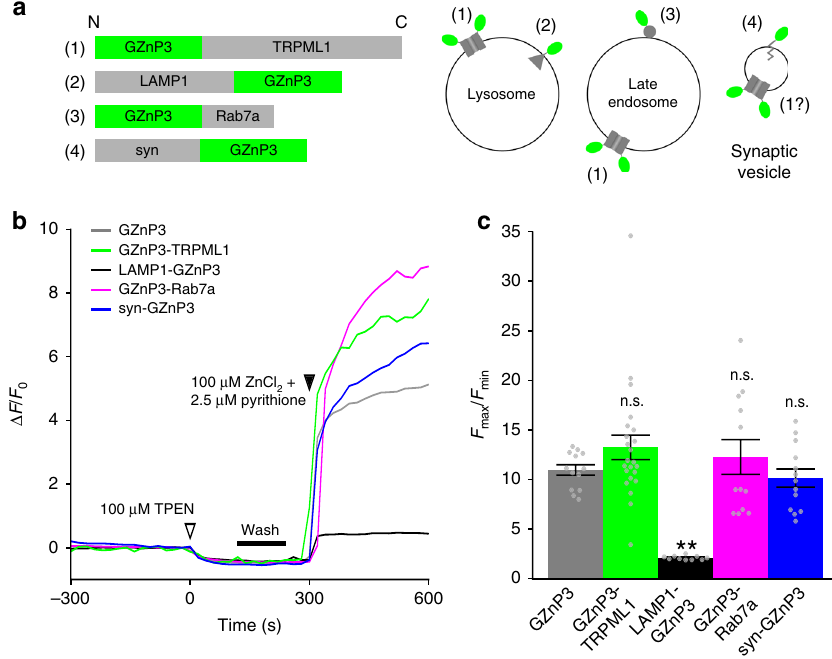
Fig. 4 Target Zn 2 + sensor to subcellular compartments to detect local TRPML1-mediated signals. a Schematic of protein constructs for (1) GZnP3-TRPML1, (2) LAMP1-GZnP3, (3) GZnP3-Rab7a, and (4) synaptophysin-GZnP3 (syn-GZnP3) with N- and C-termini marked (left). Diagram of subcellular localizations of each targeted GZnP3 construct (right). b Representative traces of HeLa cells expressing GZnP3 (gray), GZnP3-TRPML1 (green), LAMP1- GZnP3 (black) GZnP3-Rab7a (magenta), or synaptophysin-GZnP3 (blue). Cells were treated with 100 µ M TPEN at 0 s (white arrow), washed (black bar), then treated with 100 µ M ZnCl 2 and 2.5 µ M pyrithione at 300 s (black arrow). c Mean sensor dynamic range (±s.e.m.) of cytosolic control GZnP3 (gray, n = 13 cells) and vesicular-targeted variants: GZnP3-TRPML1 (green, n = 23), LAMP1-GZnP3 (black, n = 10), GZnP3-Rab7a (magenta, n = 12), and synaptophysin-GZnP3 (blue, n = 13). HeLa cells were treated as described in b . Bars indicate mean fold-change of sensor fl uorescence (F max /F min ). One- way ANOVA with Dunnett ’ s multiple comparison to GZnP3. **** p < 0.0001, n.s. not signi fi cant. p -values listed in italics above corresponding comparisons where applicable. Source data are provided as a Source Data fi